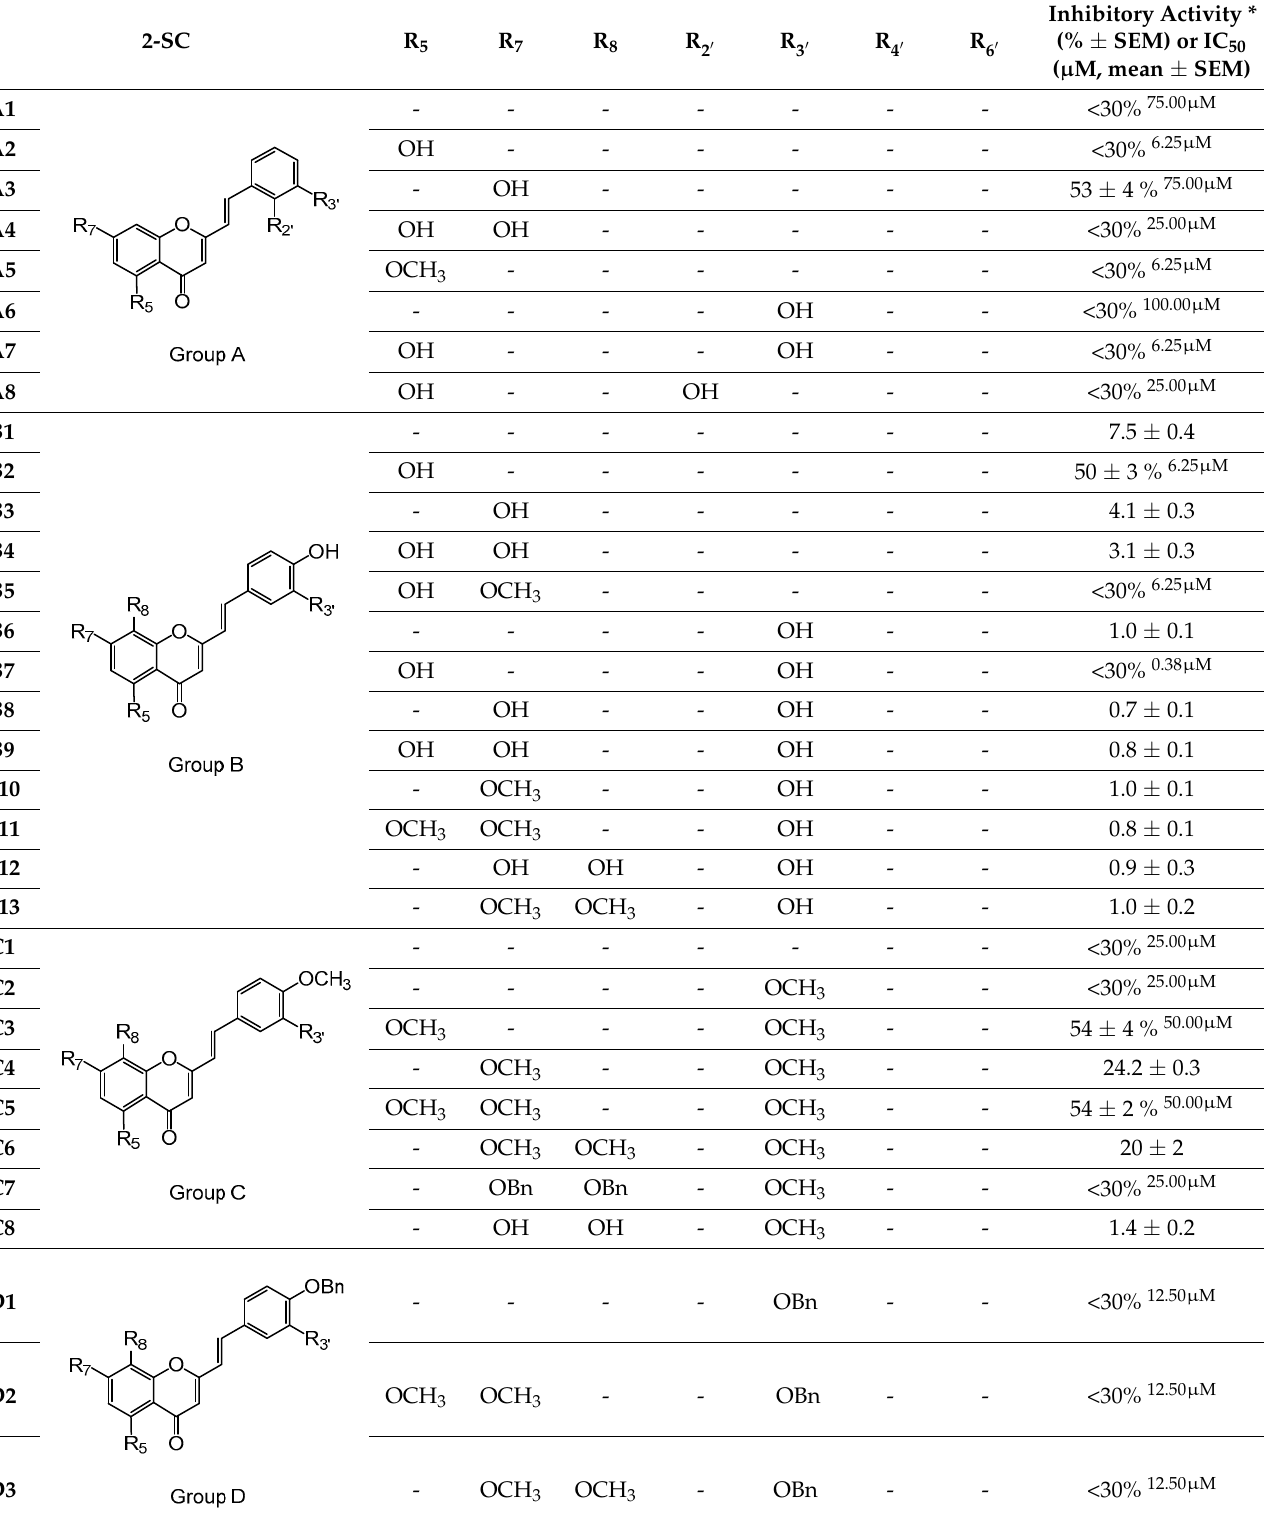
Table 2. Chemical structures and inhibition of human neutrophils’ oxidative burst by the tested 2-SC and the positive control, quercetin.